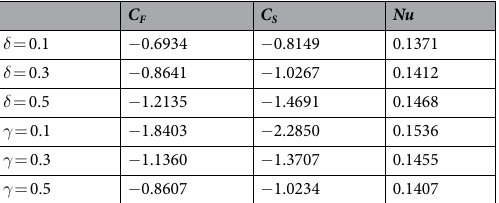
Table 3. Impact of second and first order slip parameters on C F , C S and Nu